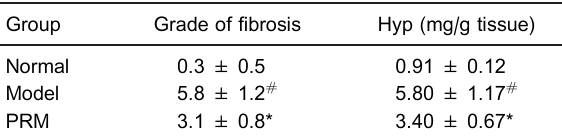
Data are reported as means±SD. PRM: pulmonary rehabilitation mixture. # P , 0.01 vs the normal group; *P , 0.01 vs the model group. Grade of fibrosis between groups was compared using the sum of ranks test. The significance of Hyp was determined by one-way ANOVA followed by Dunnett’s